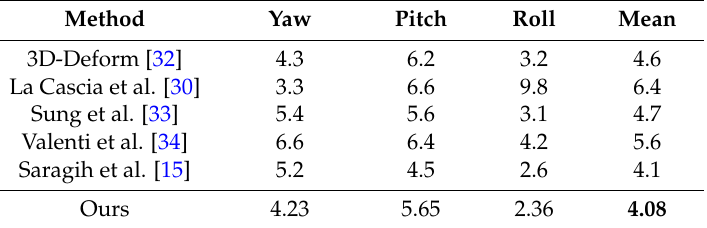
Table 1. Mean absolute error of head pose estimation results on BUFT